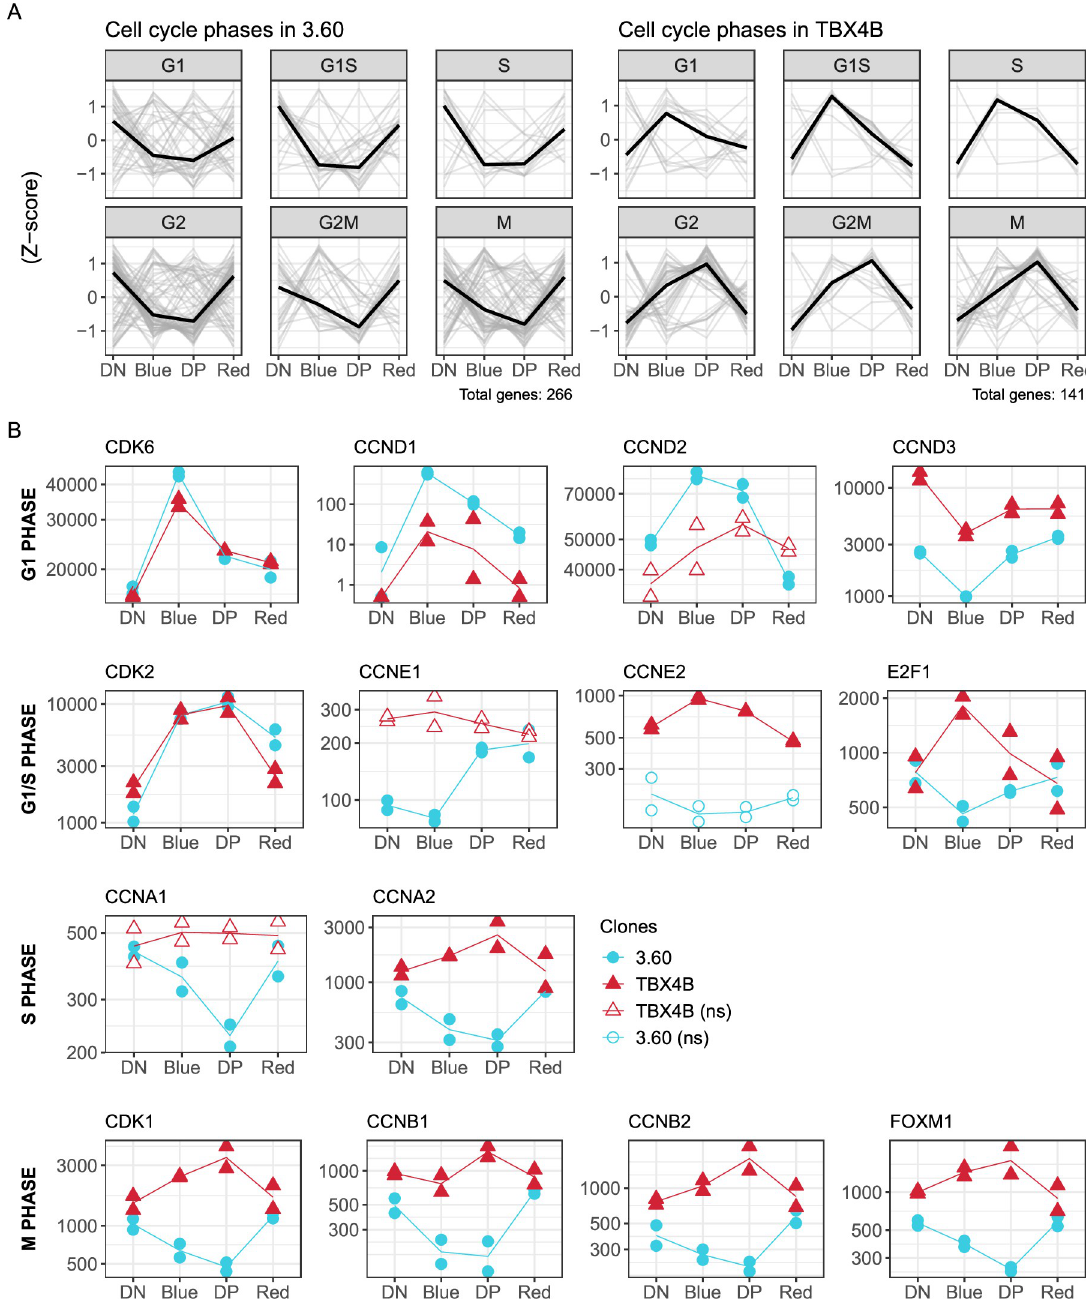
Fig 4. Divergent association between proviral plus-strand expression and genes related to the cell cycle. (A) Trajectories in each infected clone of differentially expressed Cyclebase 3.0 genes associated with G1, G1/S, S, G2, G2/M and M phases of the cell cycle. (B) Trajectories of cyclins, CDKs and transcription factors. Y-axis: normalized counts on log 10 -scale. Statistical significance was determined by LRT. FDR-corrected p-value < 0.01; ns—non-significant. https://doi.org/10.1371/journal.ppat.1010387.g004 The pattern of cyclin expression progressively diverged between the clones as the cell cycle advanced (Fig 4B). The S-phase genes CCNA1 and CCNA2 were down-regulated in clone 3.60, whereas CCNA2 was up-regulated in TBX4B. Similar contrasts in expression were observed in